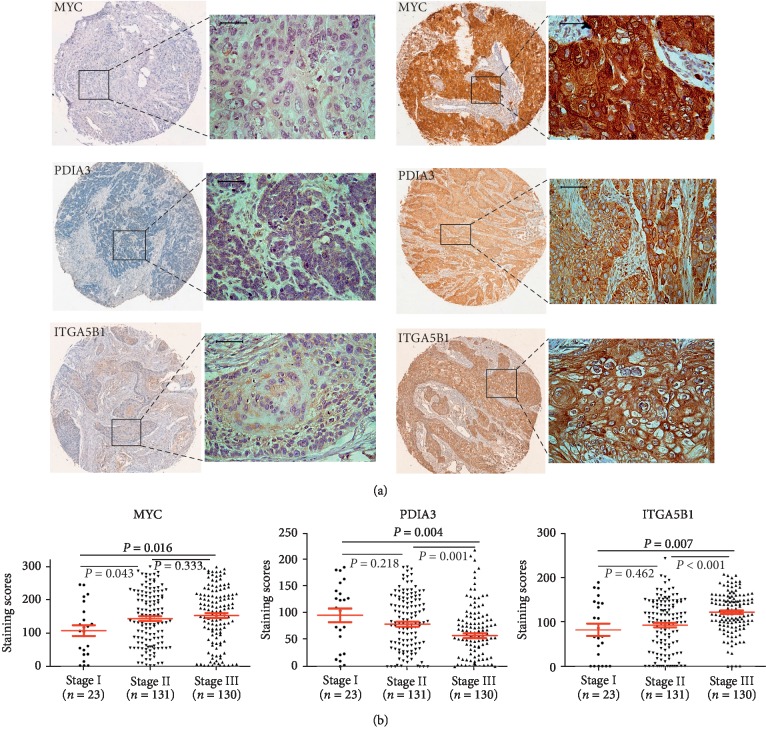
Expression of MYC, PDIA3, and ITGA5B1 in ESCC. (a) Representative images of IHC staining for MYC, PDIA3, and ITGA5B1 in ESCC samples (scale bars = 50 μm). (b) The H scores of MYC, PDIA3, and ITGA5B in different clinical stages (stages I, II, and III) of ESCC were shown by scatter diagram (P < 0.05, independent-samples t-test).